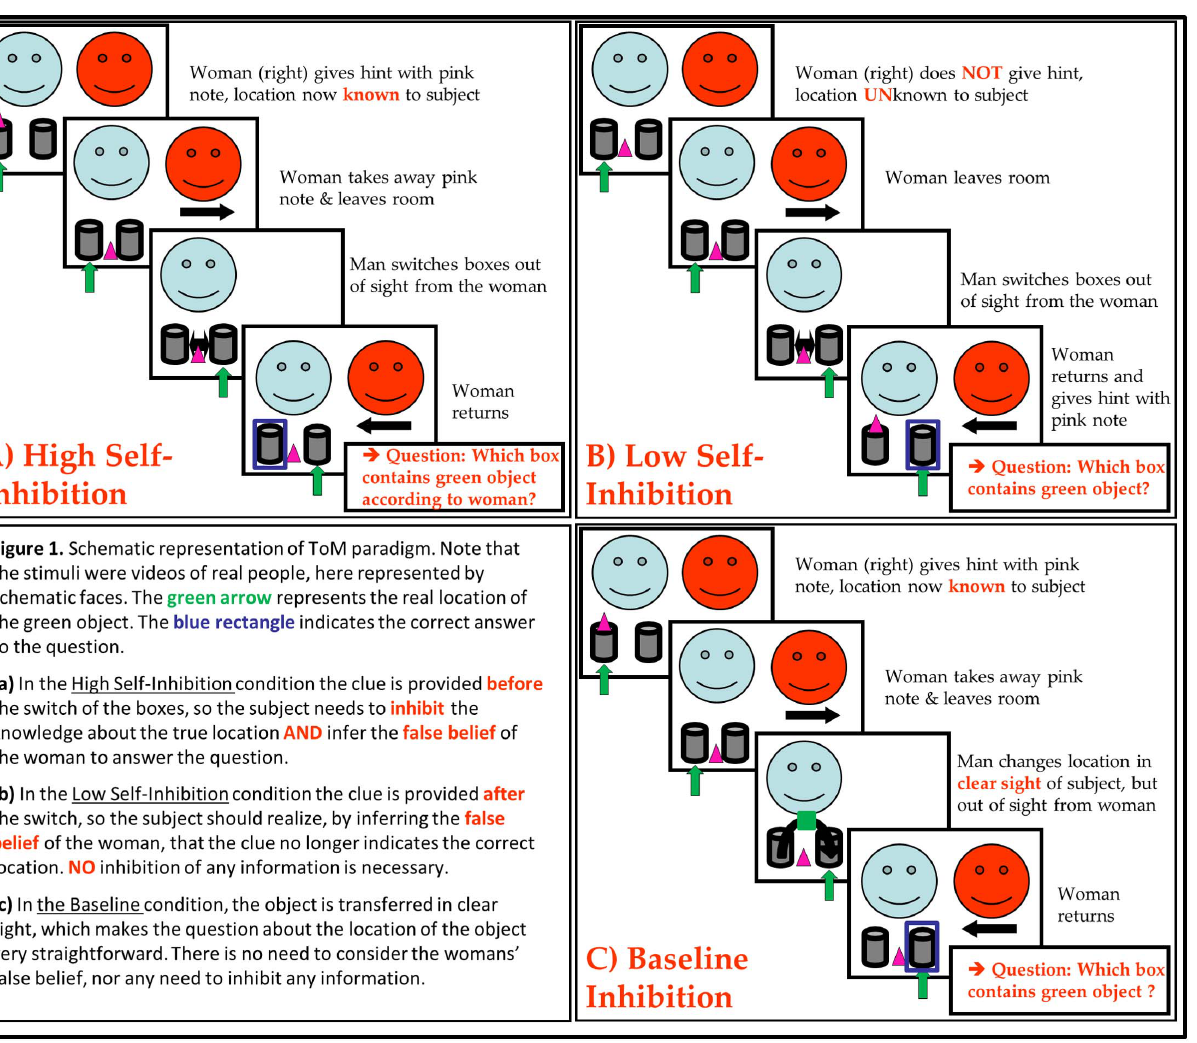
Figure 1. Schematic representation of the Theory of Mind task.